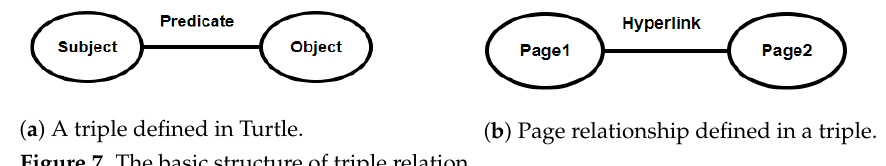
Figure 7. The basic structure of triple